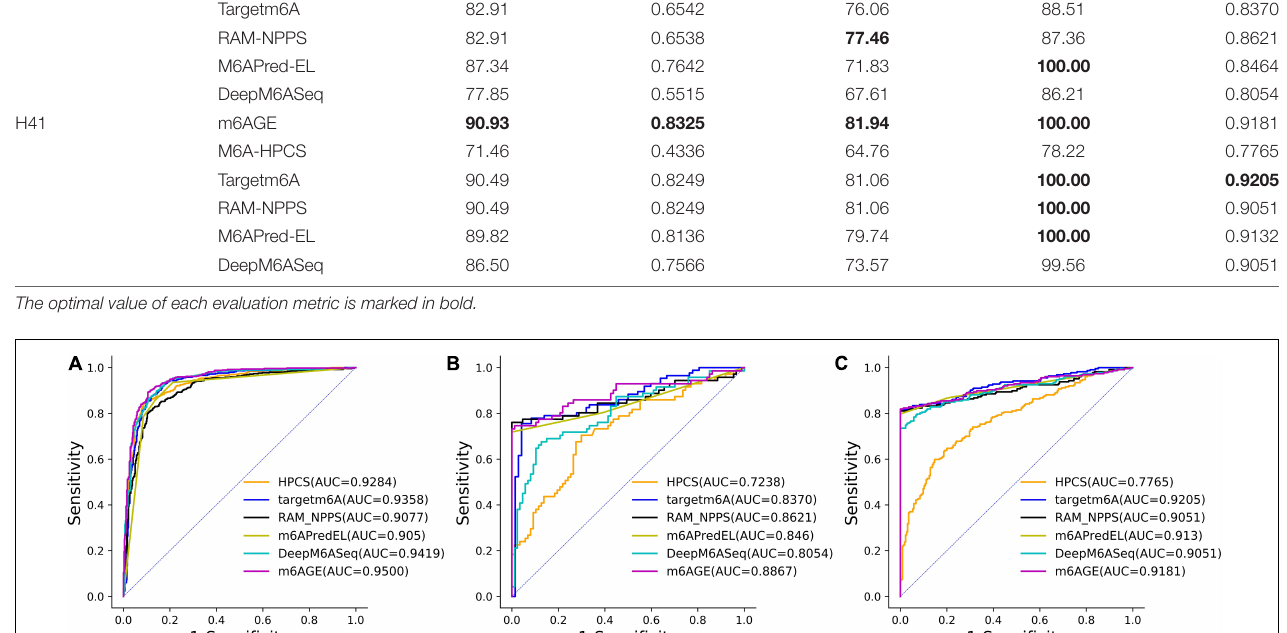
FIGURE 2 | The ROC curves of m6AGE and comparing predictors on three datasets. (A) The ROC curves on the A101 dataset. (B) The ROC curves on the A25 dataset. (C) The ROC curves on the H41 dataset.